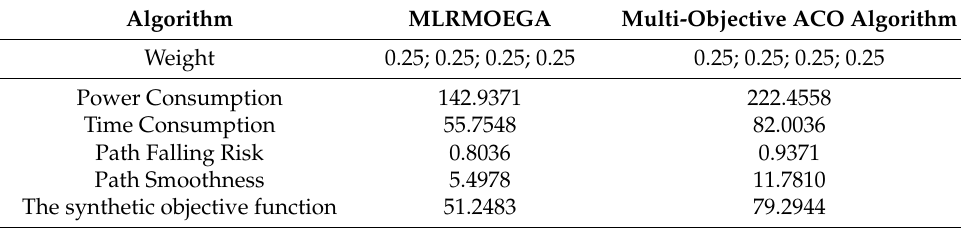
Figure 19. The test 20 × 20 grid map and paths. Table 11. Results of test compared with multi-objective ACO